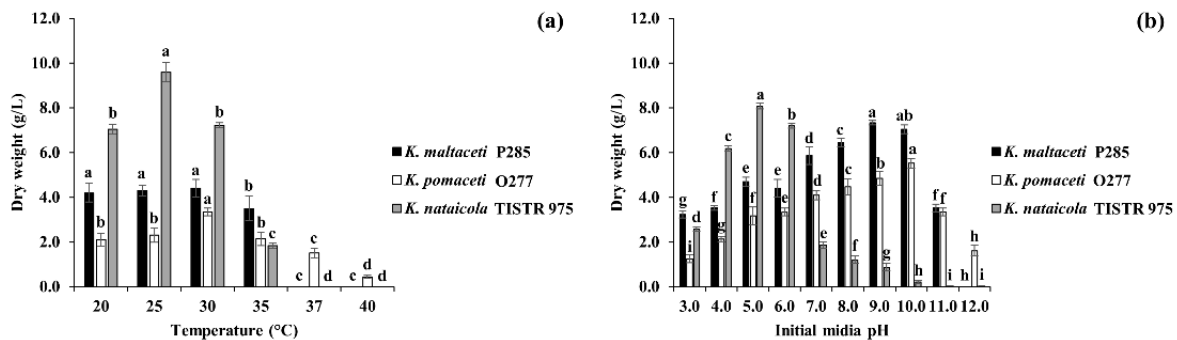
Figure 2. Effect of temperature ( a ); and initial media pH ( b ) on bacterial cellulose production by K. maltaceti P285 and K. pomaceti O277 cultured in HS medium. The K. nataicola TISTR 975 was used as control. Data expressed mean ± standard deviation ( n = 3). The difference letters were considered statistically significant ( p < 0.05) for each bacterial strain.